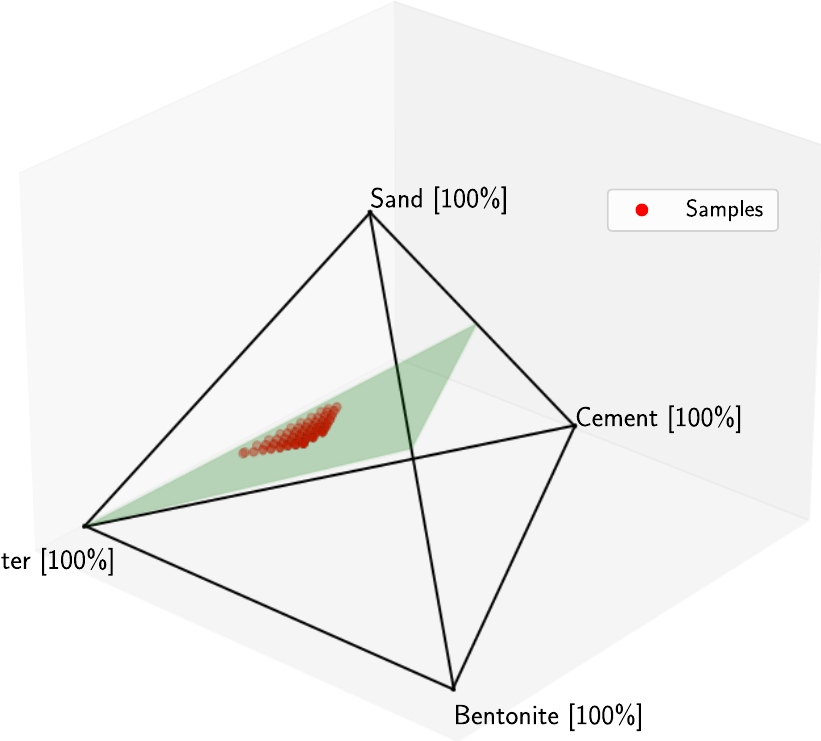
Figure 3. Ternary diagram in a 4D-barycentric representation in the plane defined by the equation Mass Sand = Mass Bentonite + Mass Cement .